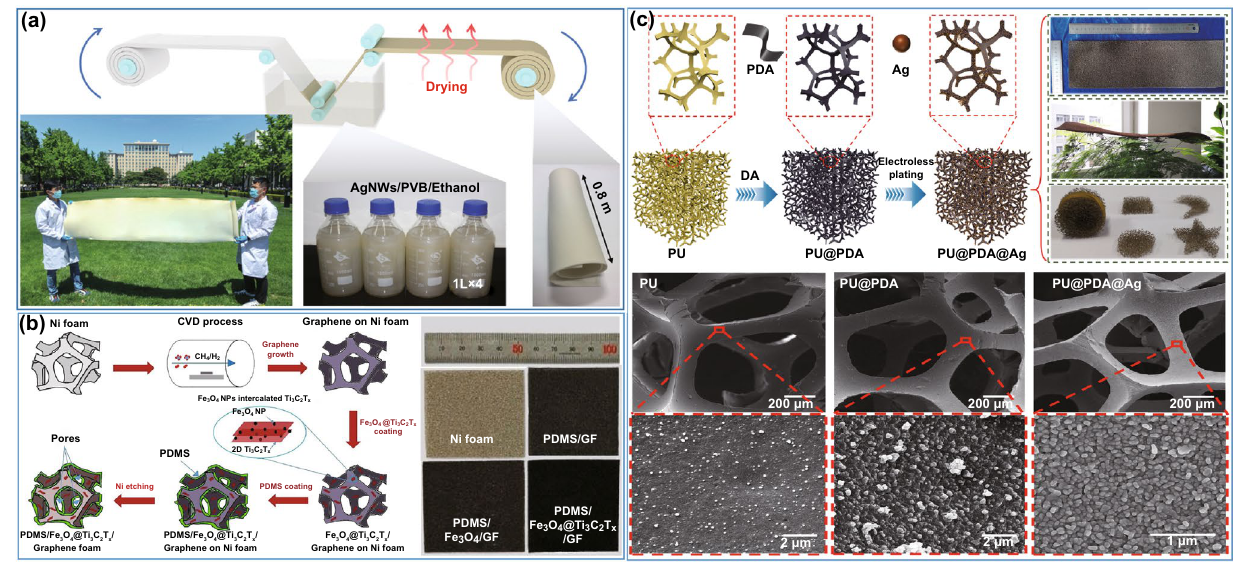
Fig. 10 Schematic illustrating the fabrication and SEM images of a AgNW/PVB/MS sponges, b Fe 3 O 4 @MXene/GF/PDMS foams, and c PU@ PDA@Ag sponges [116–118]. Copyright © 2019 Wiley–VCH. Copyright © 2020